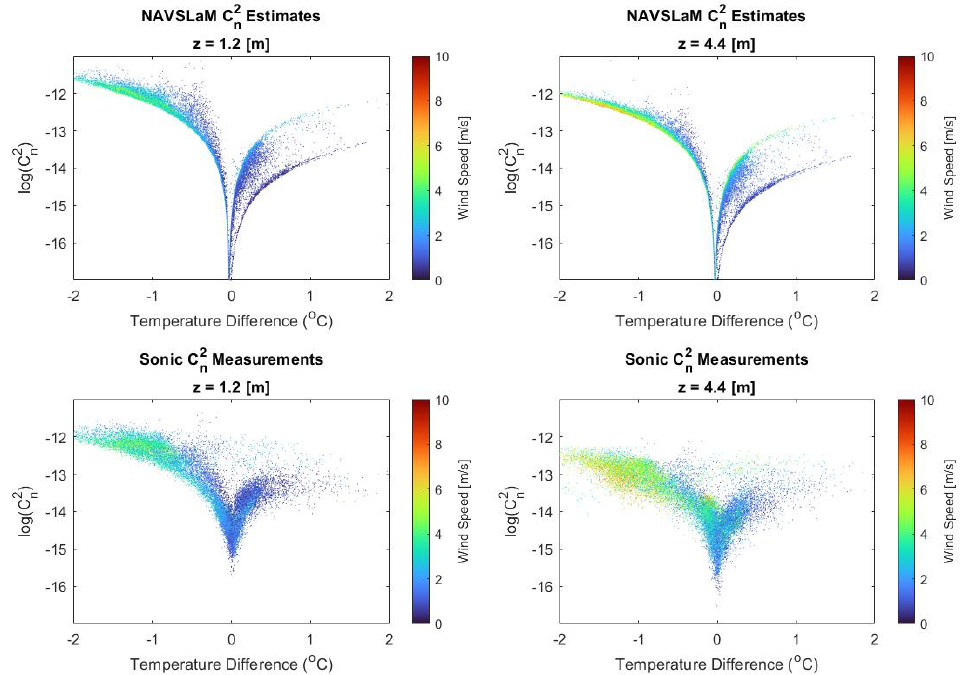
(cid:0) (cid:1) C 2 n from NAVSLaM